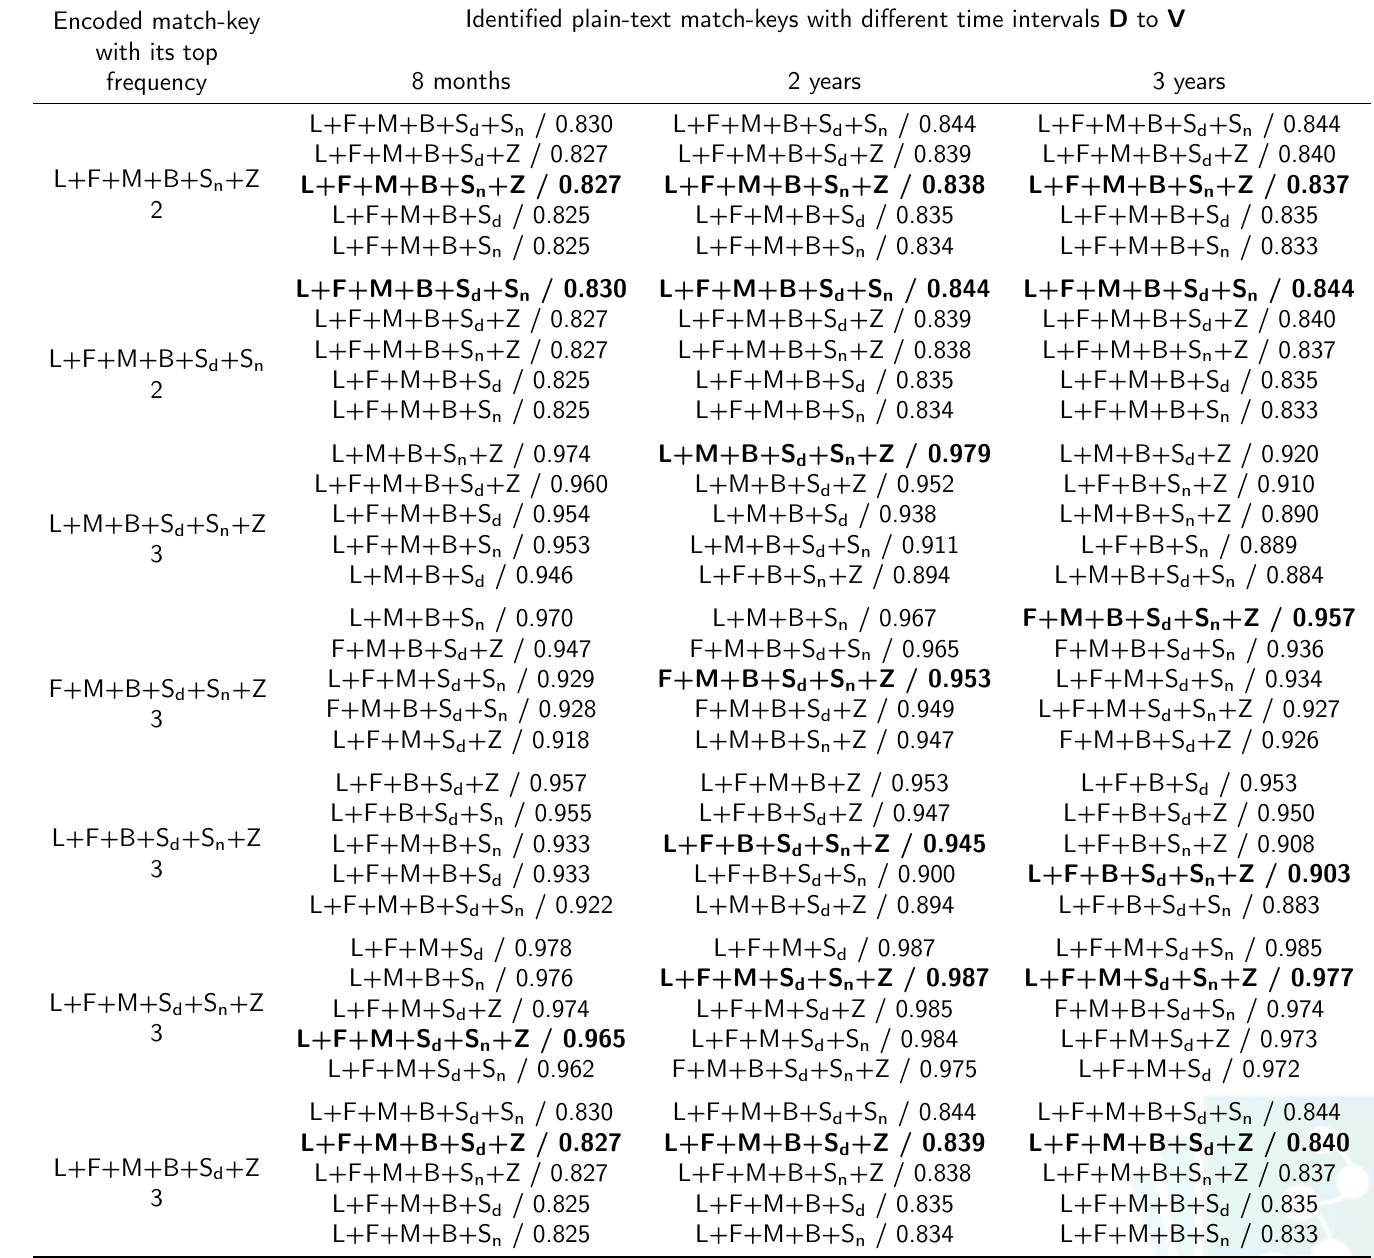
Table 5: Re-identification results of encoded match-keys for the MVR databases with different time intervals. The attributes used are FirstName (F), MiddleName (M), LastName (L), BirthYear (B), StreetNumber (S show the top five plain-text match-keys identified for each encoded match-key and the s Identified plain-text match-keys with different time intervals D to V Encoded match-key with its top 8 months 2 years 3 frequency